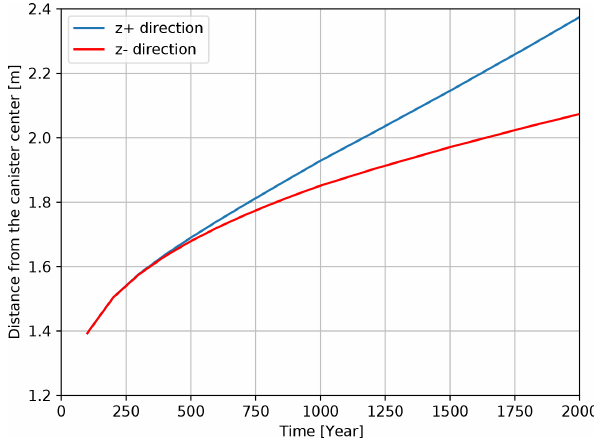
Figure 5. The moving of diffusion front along z + and z − direction versus diffusion time. The canister center is located in the position: z =